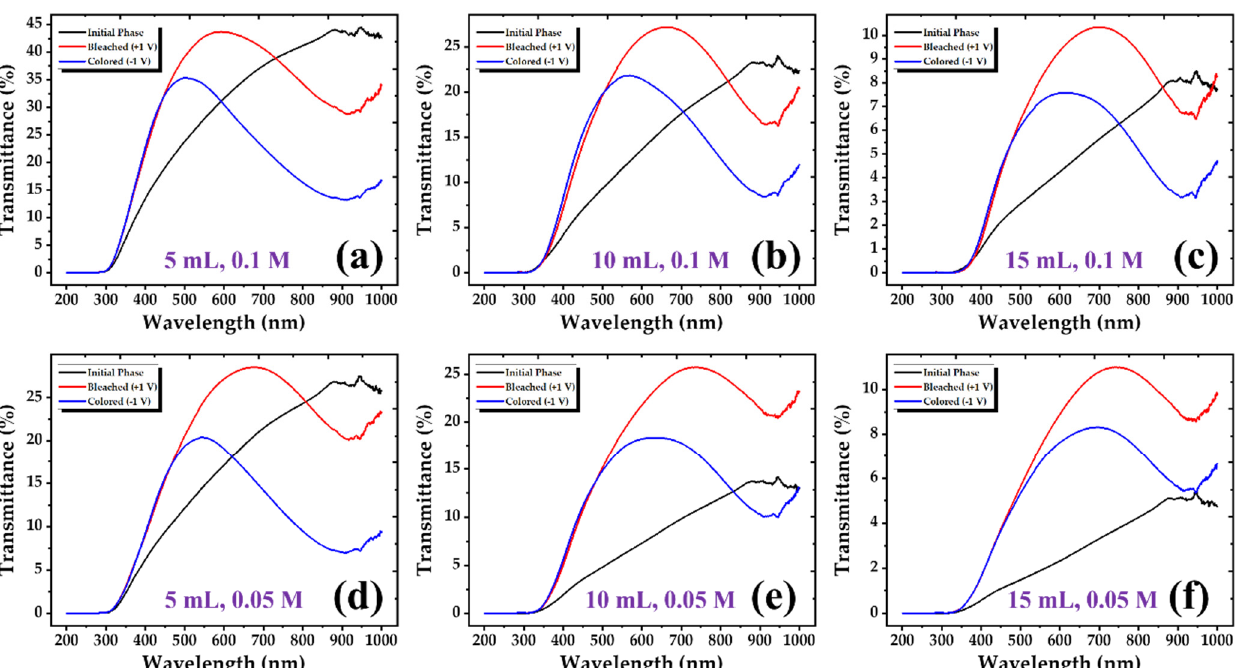
Figure 3. UV-Vis transmittance comparison of the initial, bleached and colored state of the 1st cycle of WO 3 coatings: ( a ) 5 mL with 0.1 M; ( b ) 10 mL with 0.1 M; ( c ) 15 mL with 0.1 M; ( d ) 5 mL with 0.05 M; ( e ) 10 mL with 0.05 M; ( f ) 15 mL with 0.05 M.